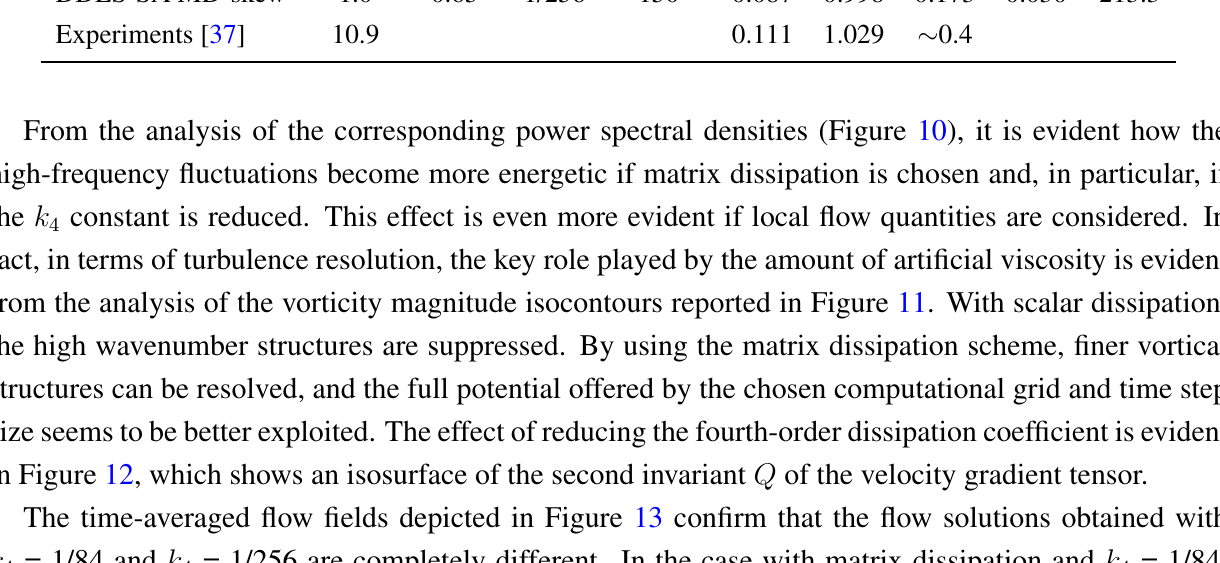
, C ) and standard deviation ( C (cid:48) D L denotes the nondimensional time units considered. NITER, INT